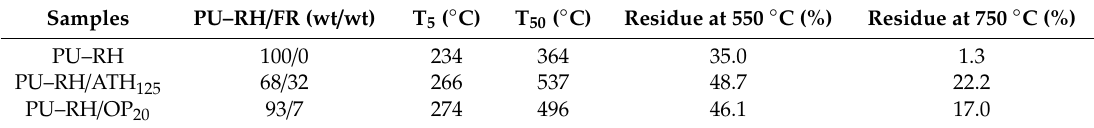
Table 3. Thermal stability parameters obtained by the